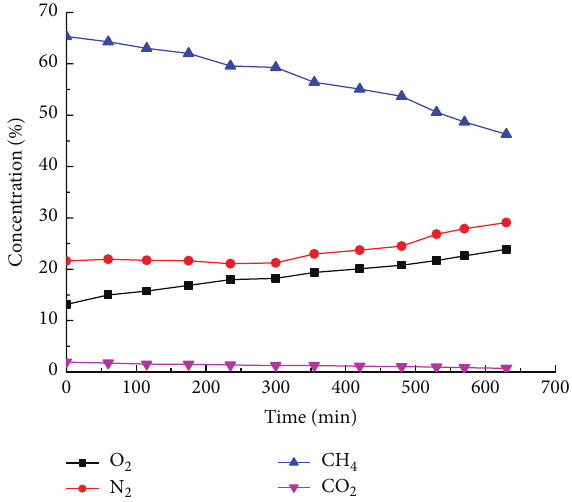
Figure 5: Gas concentration of hydrate formation in THF